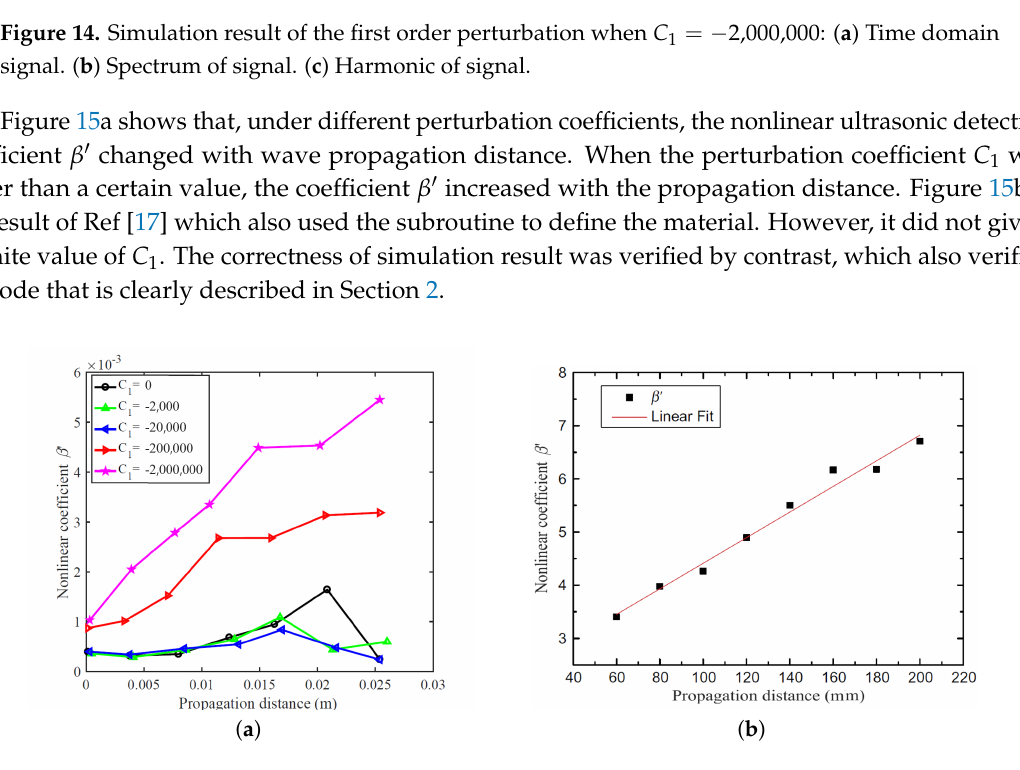
Figure 15. Coefficient β (cid:48) changes with propagation distance. ( a ) result of wave propagation model. ( b ) result from Ref